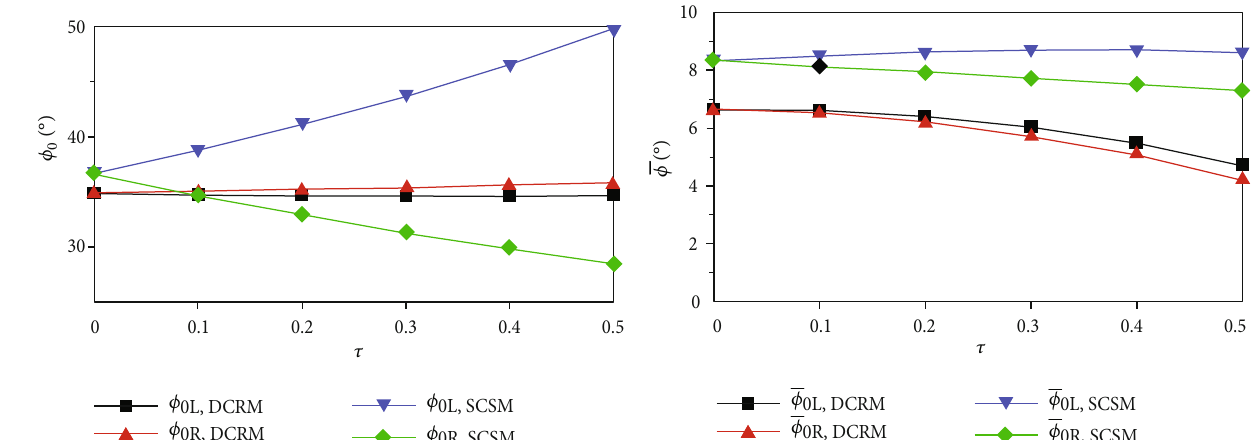
and ϕ at various τ for the DCRM and the 0